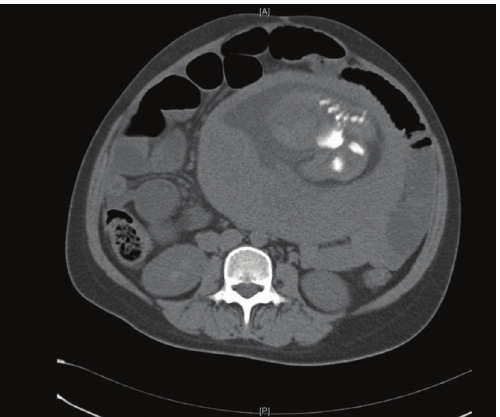
Figure 1: CT scan of patient showing dilated small bowel loops and part of the